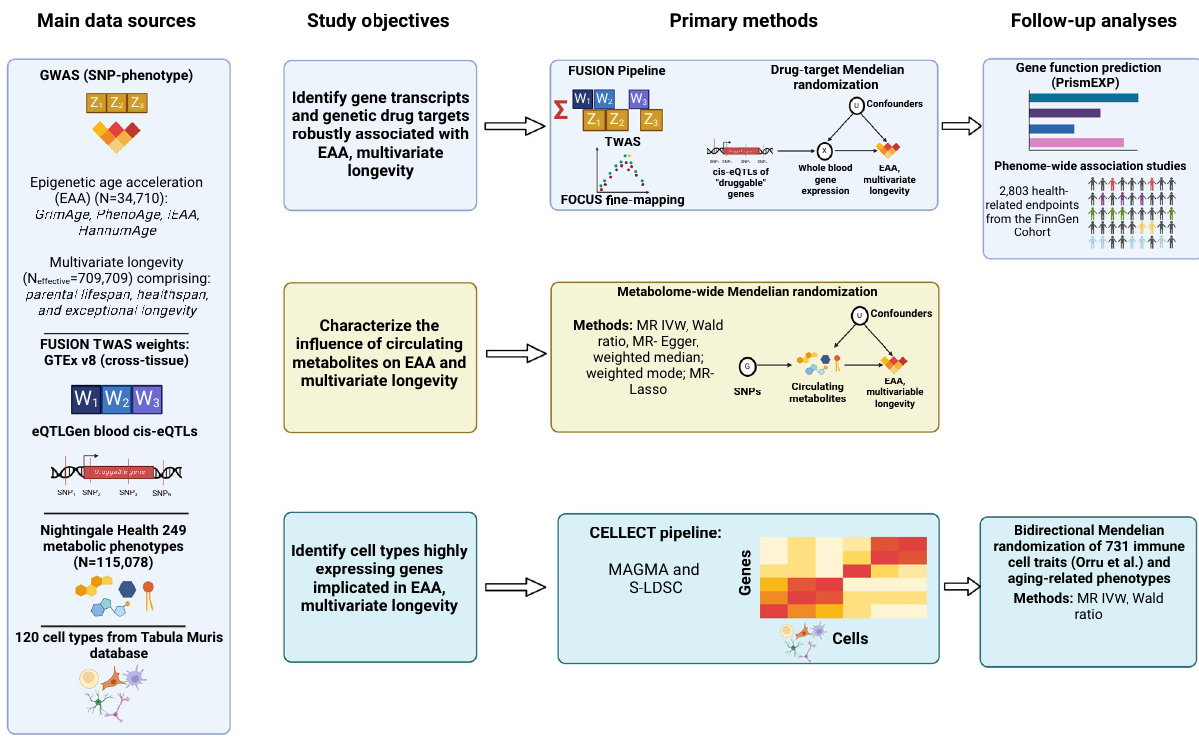
Fig.1|Studyoverview. Anoverviewofthisstudy ’ sdatasources,analytical fl ow,and methodology. Created with BioRender.com. IEAA intrinsic epigenetic age accelera- tion, TWAS transcriptome-wide association study, SNP single nucleotide poly- morphism,eQTLexpressionquantitativetraitloci,GTExGenotype-TissueExpression Project, IVW inverse variance weighted, CELLECT CELL-type Expression-speci fi c